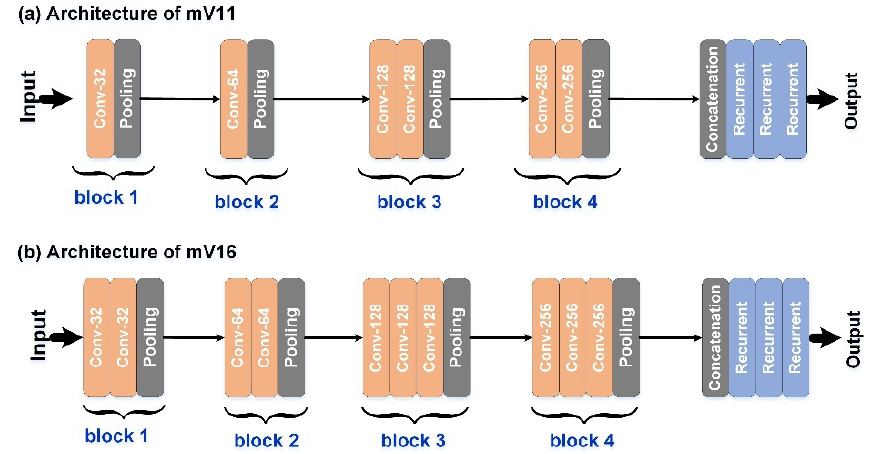
Figure 3. Architecture of the modified VGGNet networks: ( a ) mV11 and ( b ) mV16.